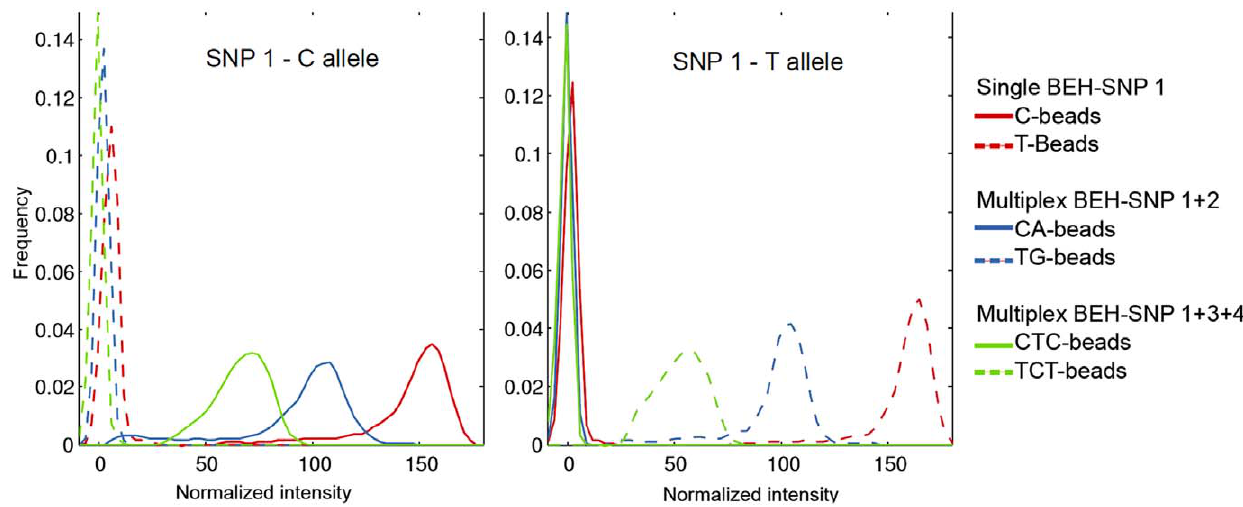
Figure 2. Distribution of the fluorescence intensity of the same target (SNP 1) common in all three experiments amplified with one, two or three targets. The intensity was normalized for the two fluorphores used per polymorphism. The high peak on the left represents empty beads without an amplification product.